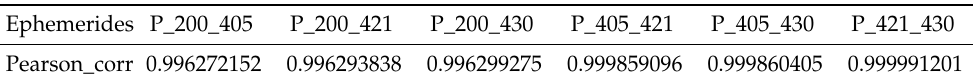
Figure 4. Comparison of standard pulse profiles after correcting system deviation. ( a ) Integral period profiles; ( b ) Partial period profiles. Table 3. Pearson correlation coefficient between pulse profiles. P_200_405 represents the Pearson correlation coefficient between DE200 profile and DE405 profile, and the rest are analogous.